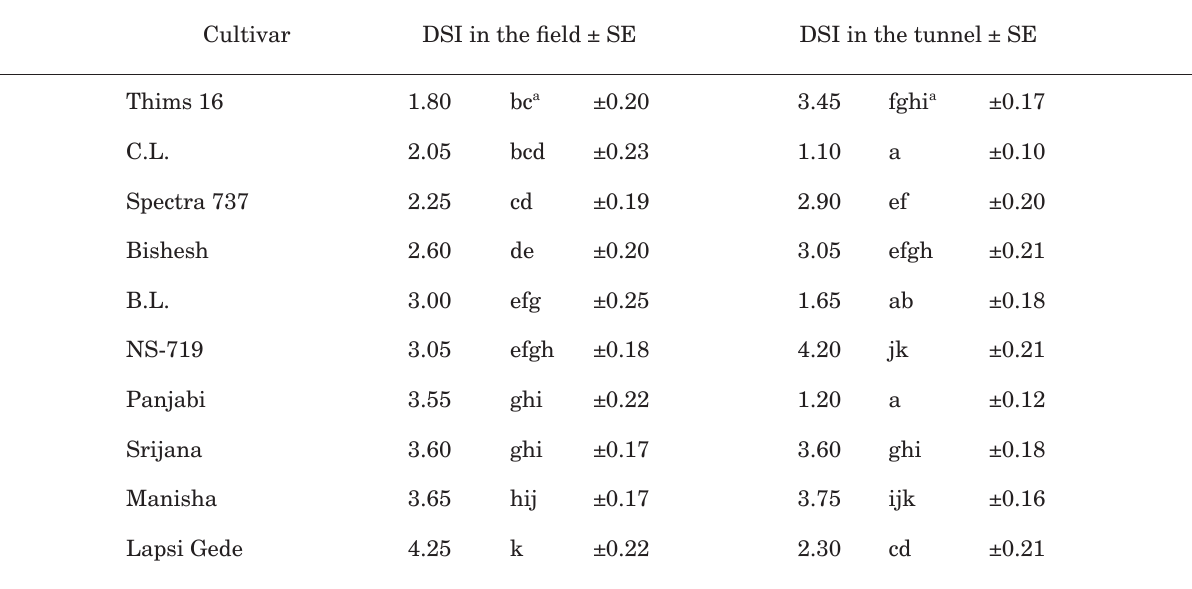
Table 1. Disease severity index (DSI) in the field and in a tunnel for tomato cultivars 10 days after inoculation with Pseudomonas syringae pv . tomato (PST